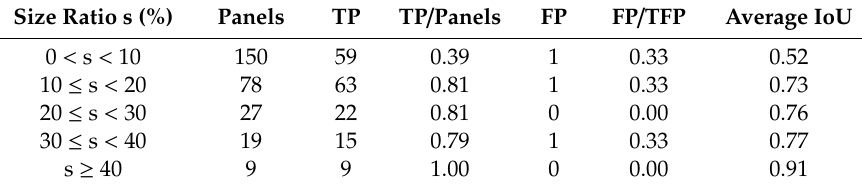
Table 5. Detection results for SSD network in relation with panel size ratios.